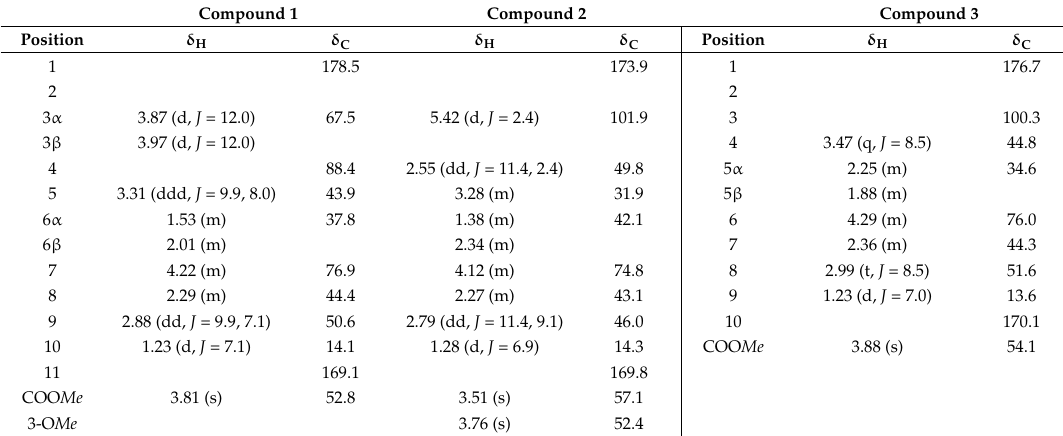
Table 1. NMR data (CDCl 3 ) of compound 1 – 3 in ppm, with J in Hz. Compound 1 Compound 2 Compound